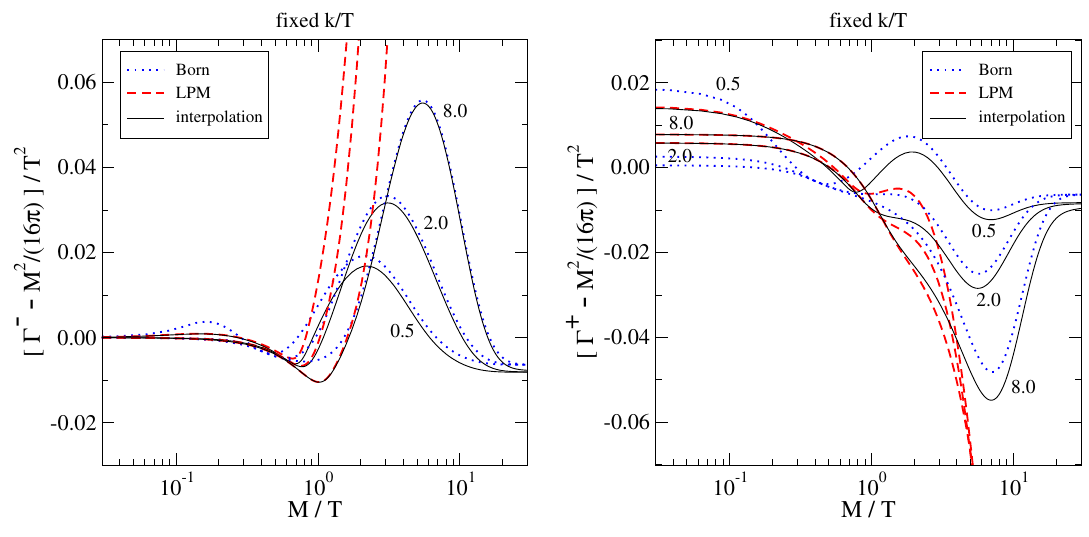
Figure 2 . Results for the right-handed neutrino interaction rates in the τ = − (left) and τ = + (right) channels, after the subtraction of the leading-order vacuum contributions at M (cid:29) m eq. (5.1). The value of k/T has been indicated next to the